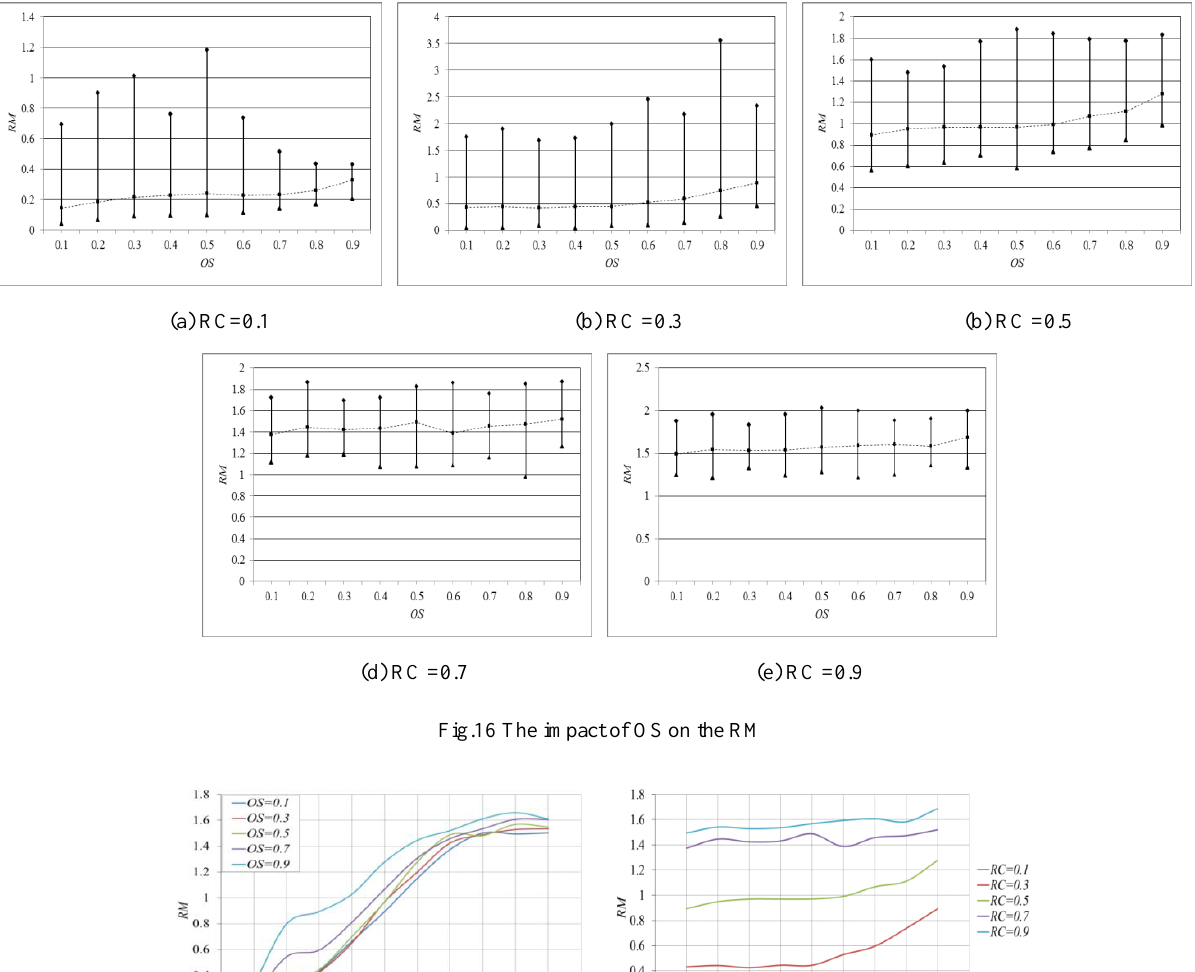
Fig.17 The impacts of RC and OS on the